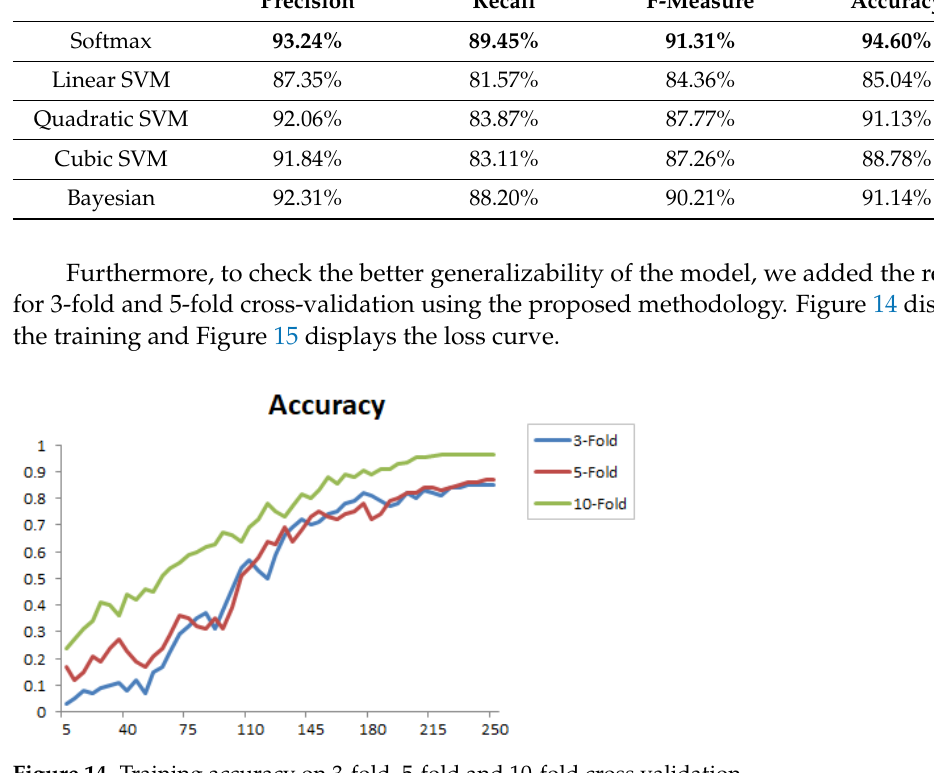
Figure 14. Training accuracy on 3-fold, 5-fold and 10-fold cross validation.